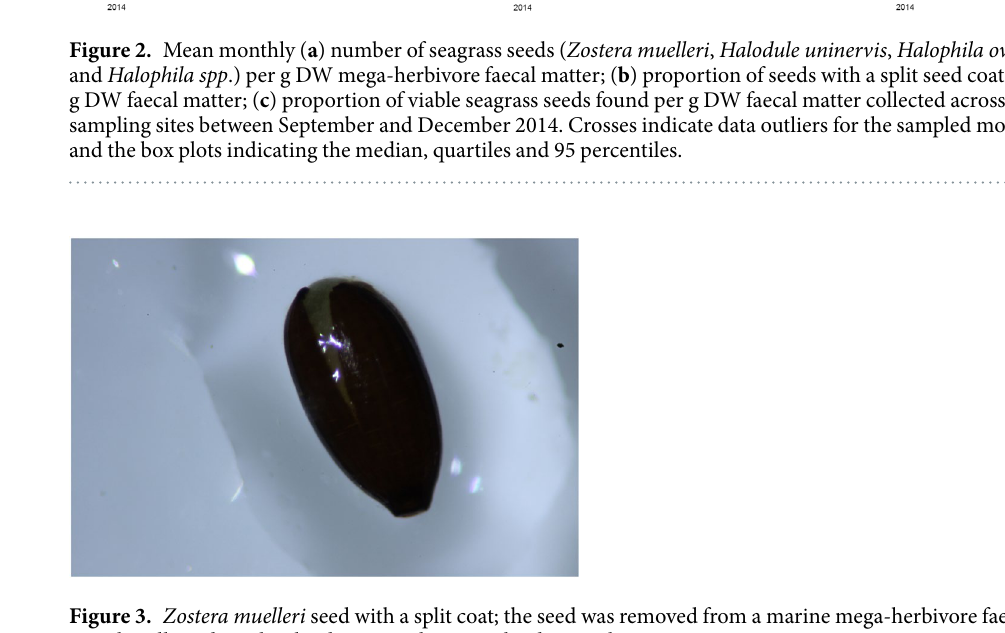
dispersal by marine mega-herbivores.